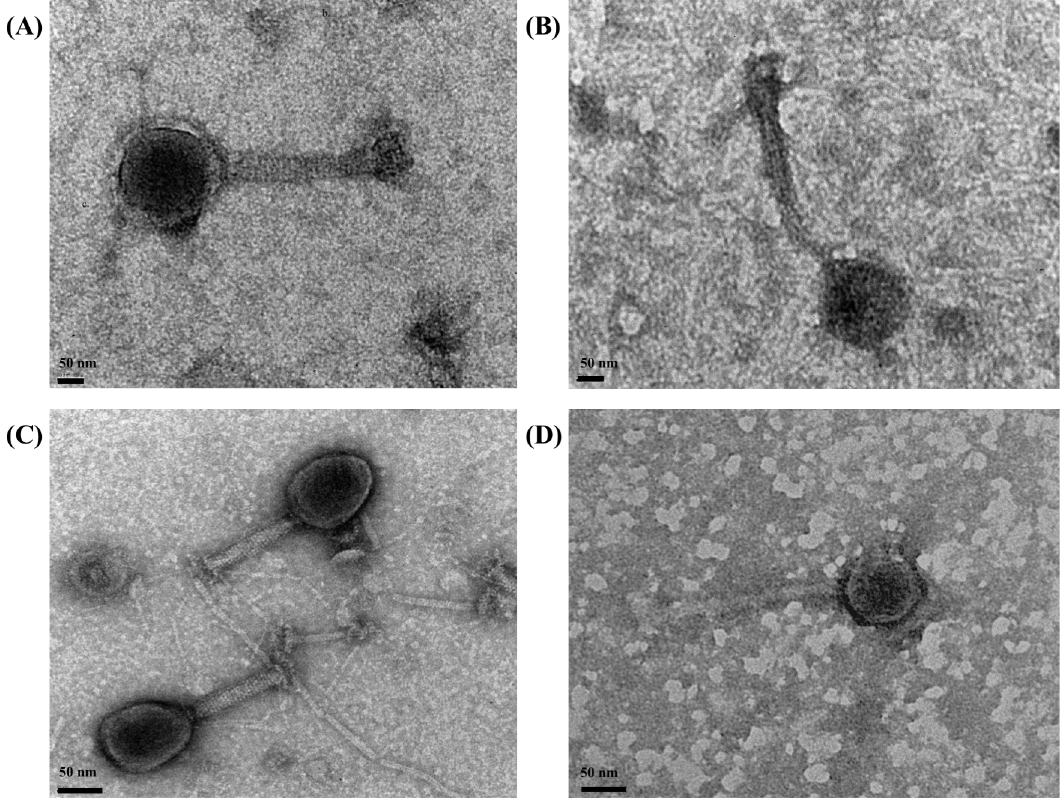
Fig 4. The morphology of the STEC-specific phages isolated from Salinas area. (A) O157-specific bacteriophage, (B) O145-specific bacteriophage, (C) O45-specific bacteriophage, (D) O179-specific